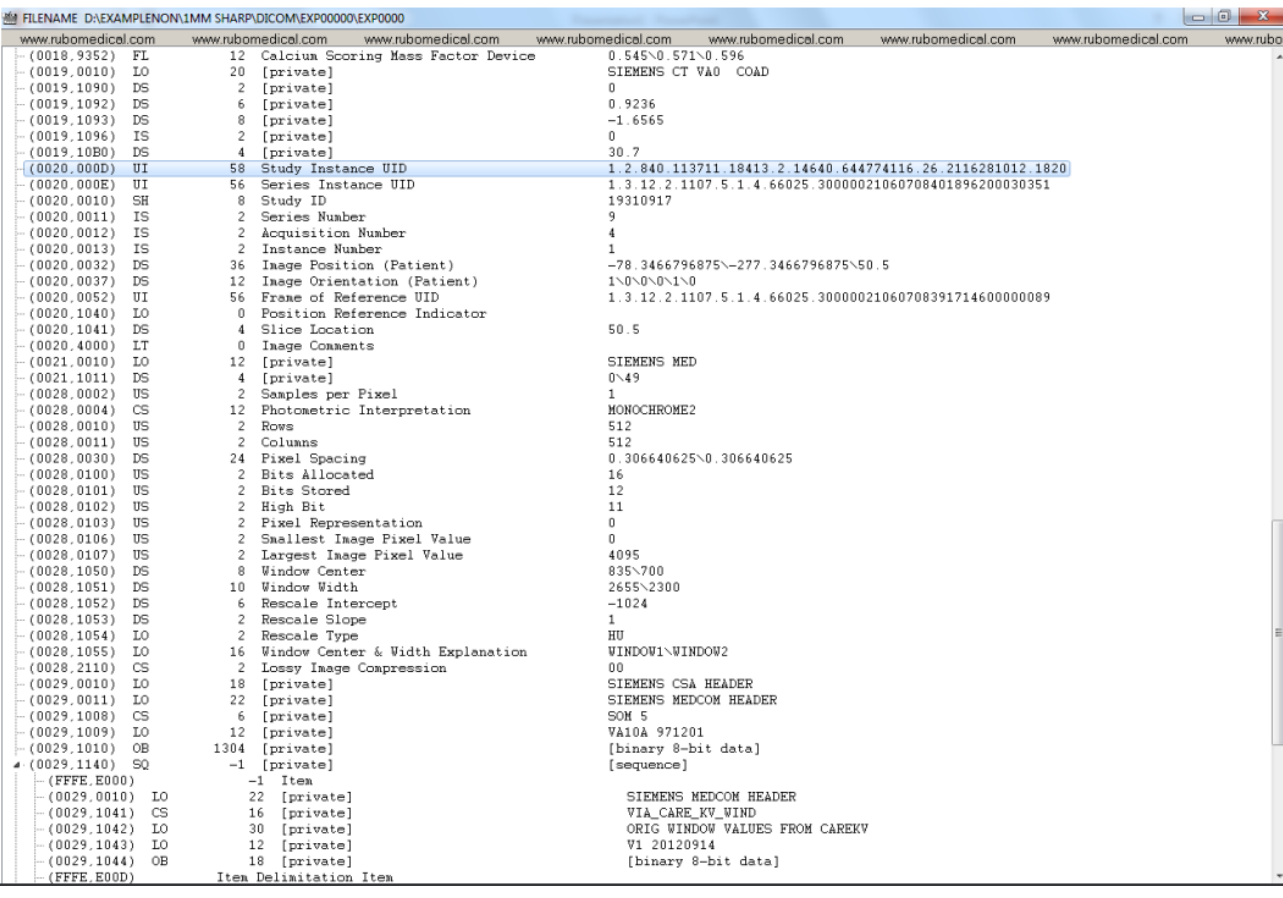
Figure A3. DICOM header data before de-identification (part 3).